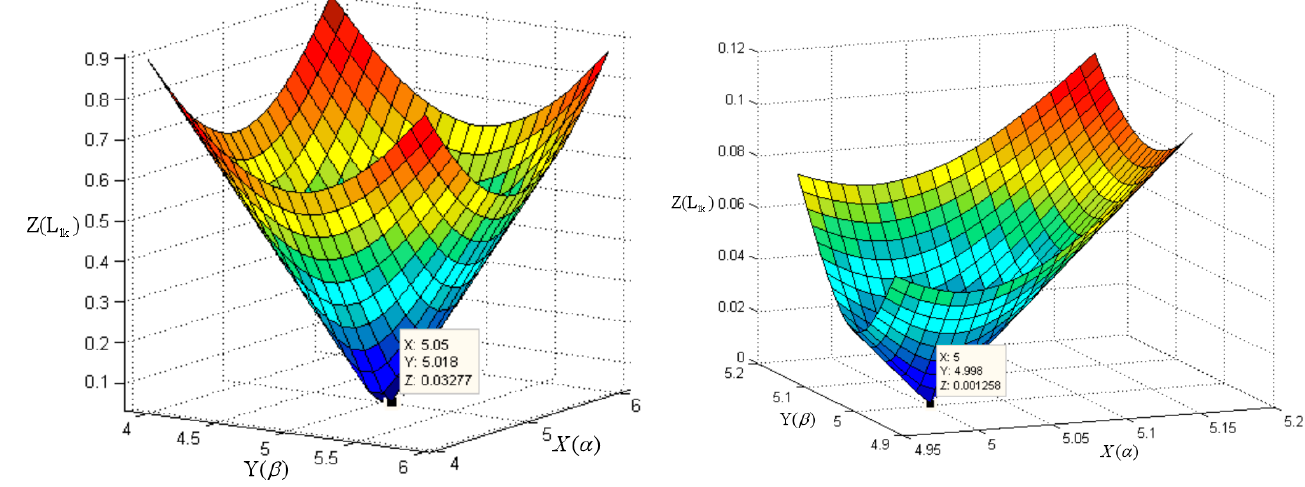
Figure 6. High-precision perpendicularity error search chart with 0.1°and 0.01°steplength.